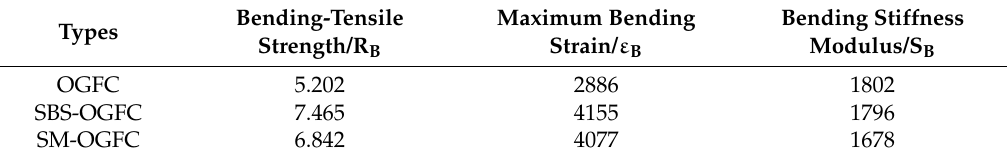
Table 10. Low-temperature beam bending test results of all OGFC mixtures.